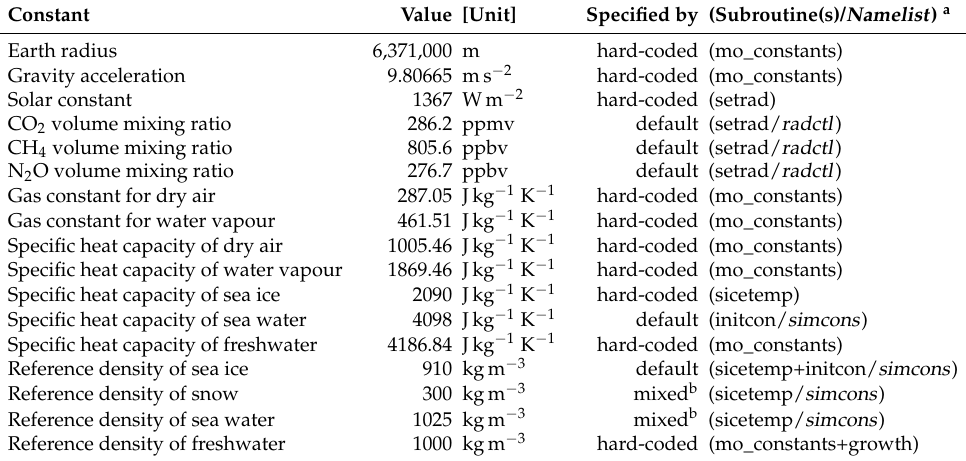
Table A3. Physical constants used in the base configuration of